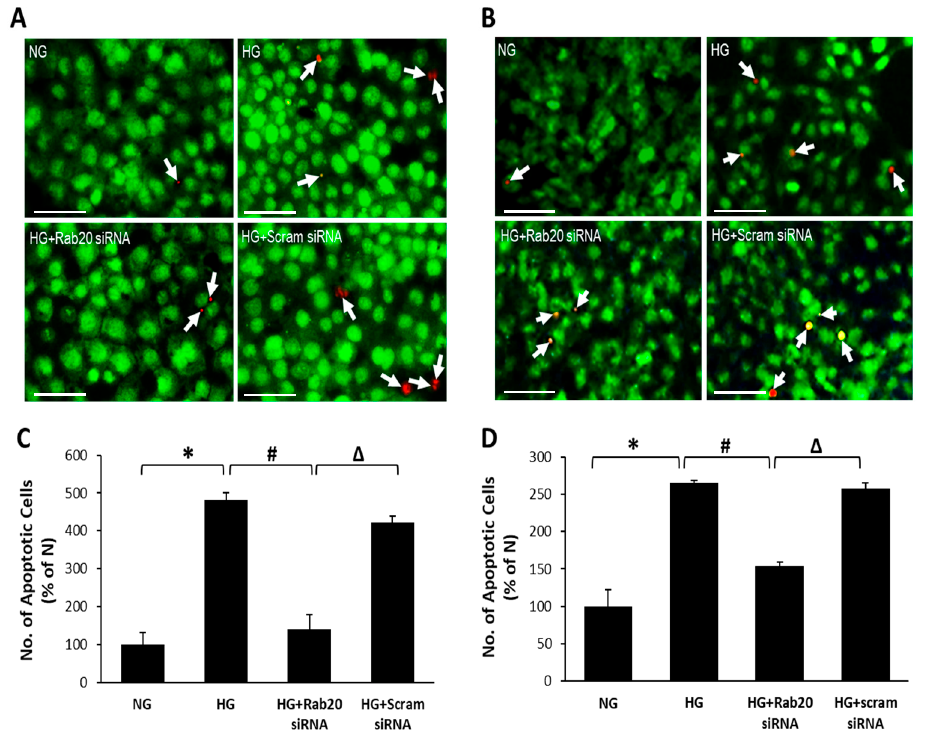
Figure 4. Inhibition of HG-induced Rab20 overexpression protects RRECs and rMC-1 from HG-induced apoptosis. ( A ) Differential staining assay shows an increased number of apoptotic cells under HG condition, which was abrogated by Rab20 downregulation. ( B ) Representative images of cells undergoing apoptosis (white arrows). Scale bar = 50 μ m. Graphical illustrations of cumulative data indicate that downregulation of Rab20 expression rescues ( C ) RRECs (* p < 0.01, n = 6; # p < 0.05, n = 6; Δ p < 0.05, n = 6) and ( D ) rMC-1 (* p < 0.05, n = 6; # p < 0.05, n = 6; Δ p < 0.05, n = 6) from HG-induced apoptosis. Data are expressed as mean ± SD.